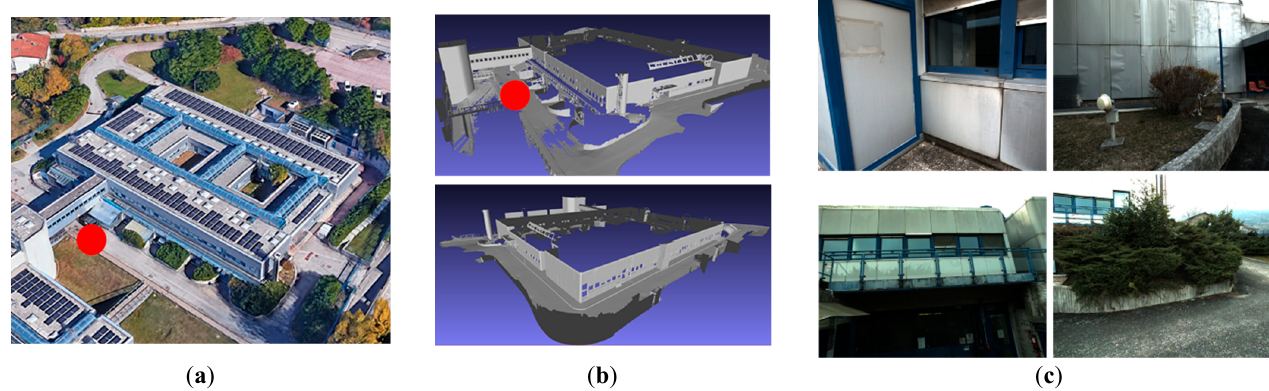
Figure 9. The FBK’s building used for the device’s accuracy evaluation: ( a ) aerial view (Google Earth) and ( b ) laser scanning mesh model used as ground truth. The red dot is the starting/ending surveying position. ( c ) Some of the acquired images of the building: challenging glasses, reflections, repetitive patterns, poor texture surfaces and vegetation are clearly visible.